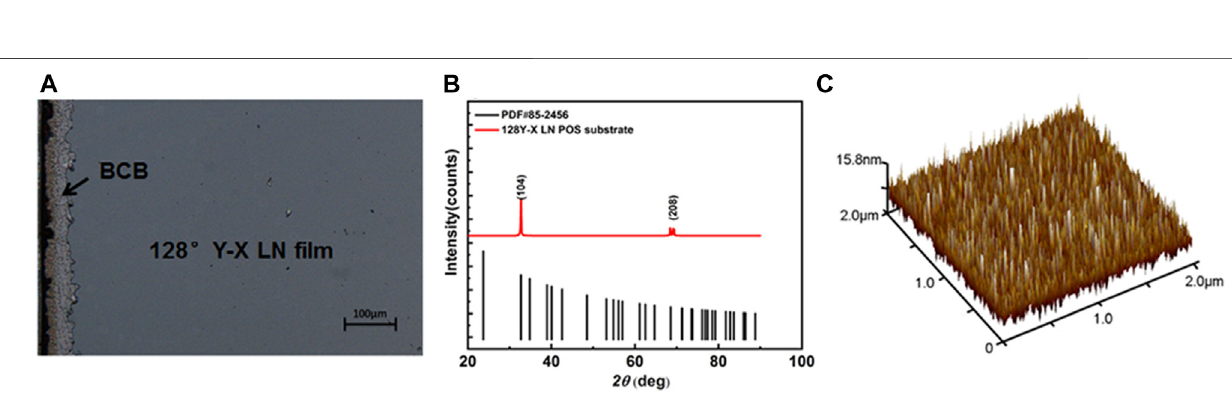
Frontiers in Materials |